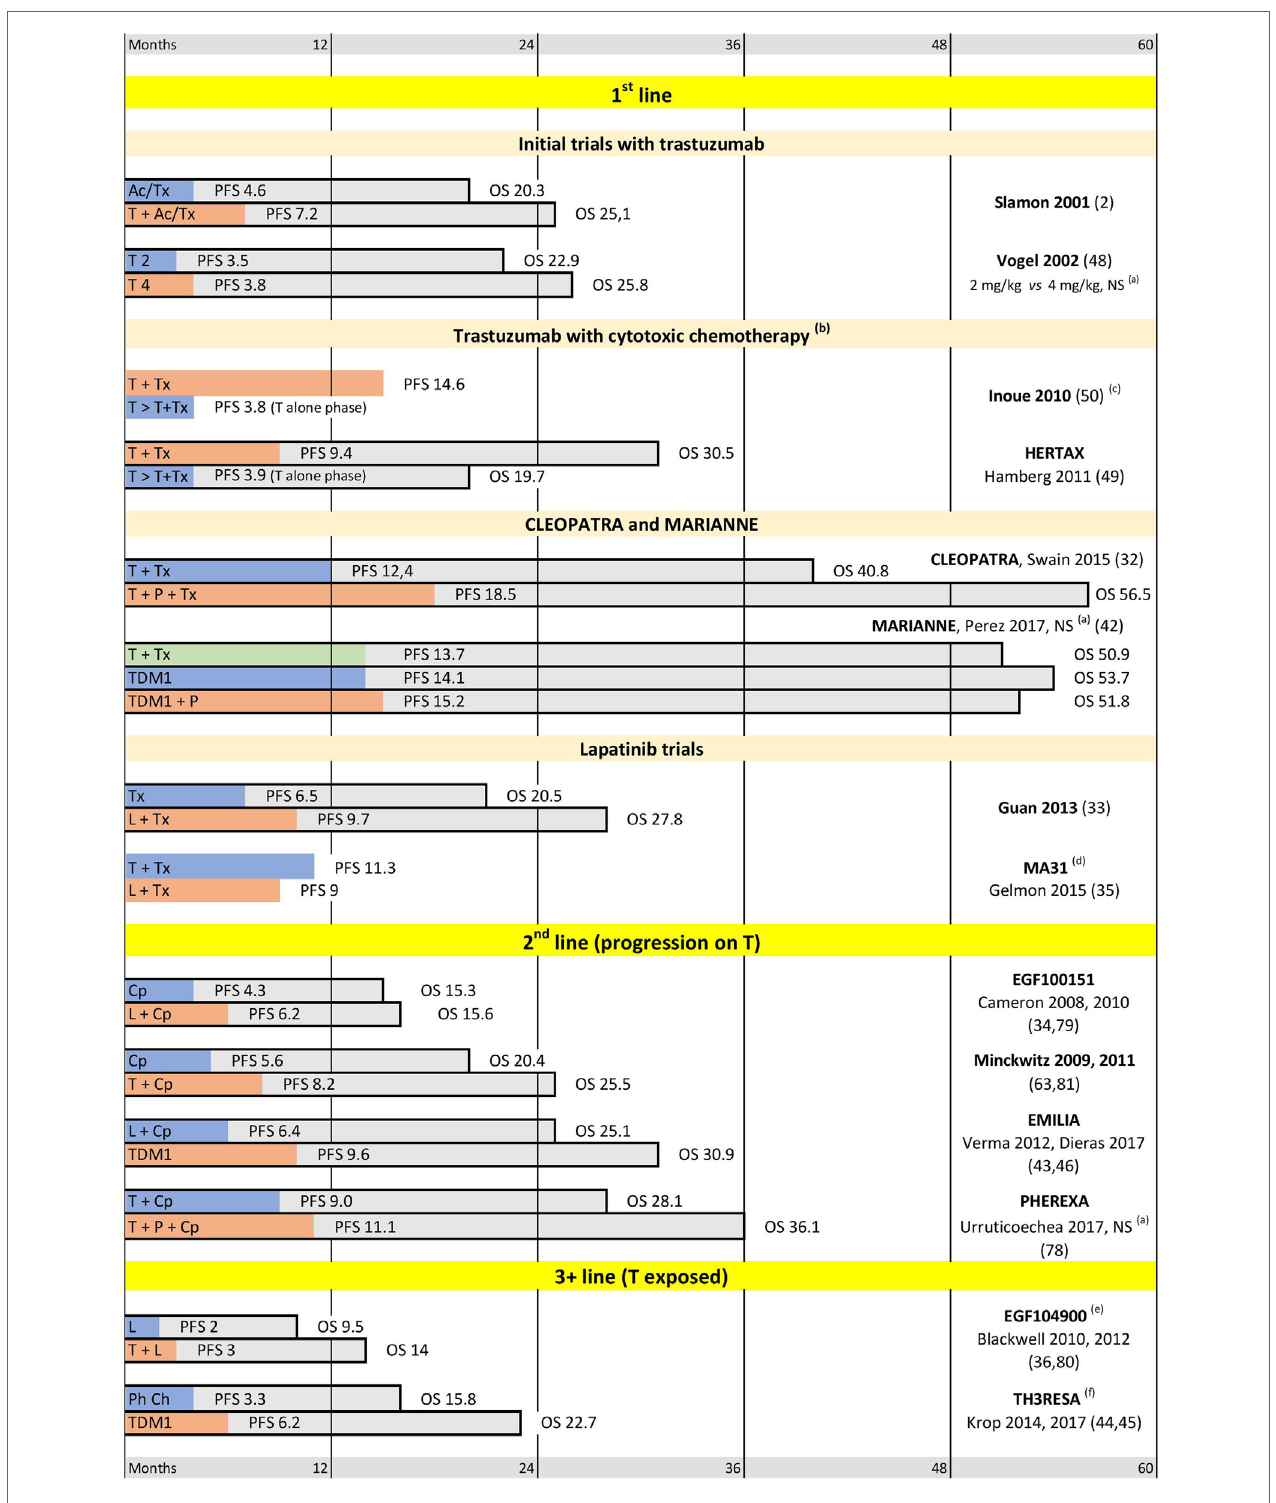
FiGURe 2 | Selected trials supporting current practices in human epidermal growth factor receptor 2 (HER2)-positive metastatic breast cancer (MBC). Abbreviations: T, trastuzumab; P, pertuzumab; L, lapatinib; Tx, taxanes; Cp, capecitabine; Ac, anthracyclines; Ph Ch, physician choice. (a) Difference between arms is not significant. (b) In the sequential arm Tx is added after progression on T alone. Median progression-free survival (PFS) is shown for T alone phase only. (c) Median overall survival (OS) is in favor of T + Tx, median OS not reached. (d) OS not reported. (e) After 3 T-containing lines on average. (f) After at least 2 metastatic lines. Median PFS and OS are indicated in